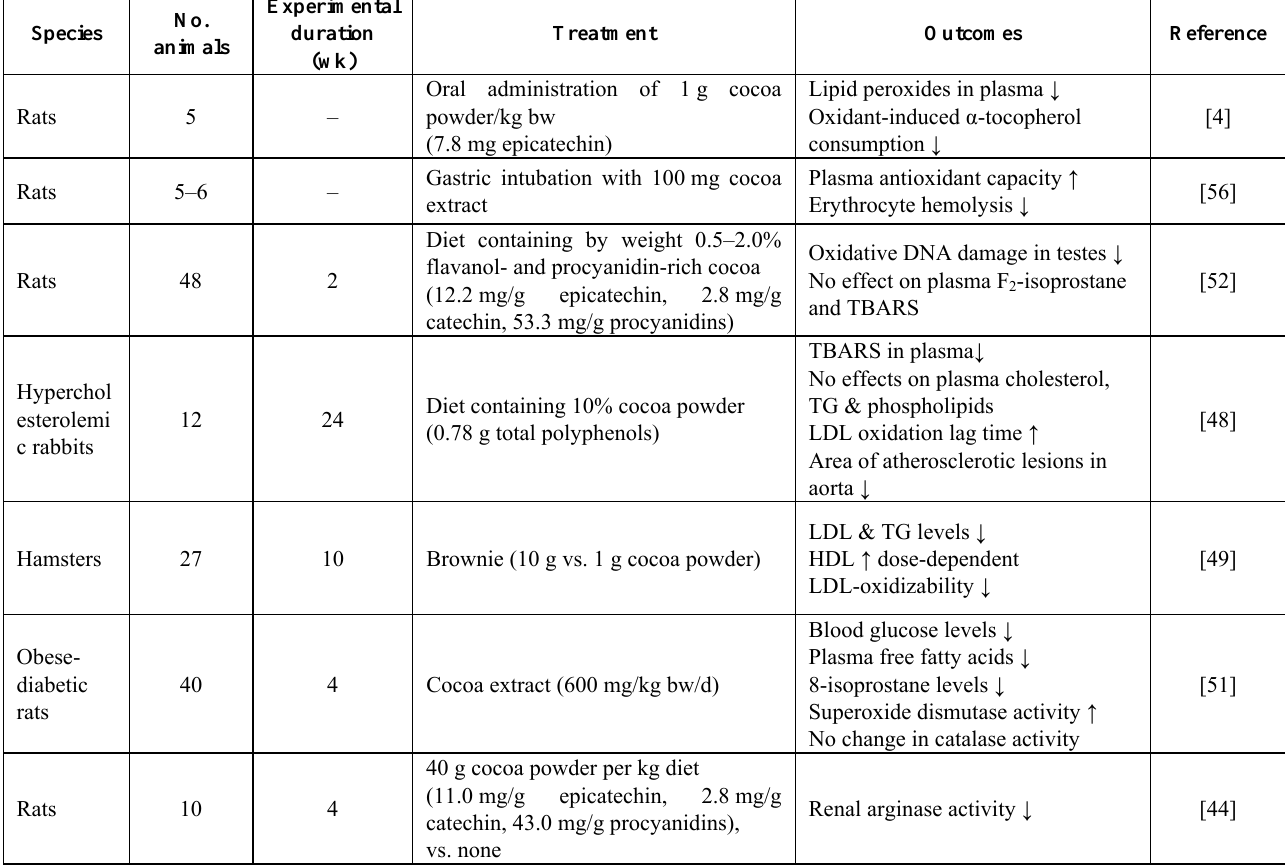
Table 4. In vivo studies with cocoa polyphenols in laboratory